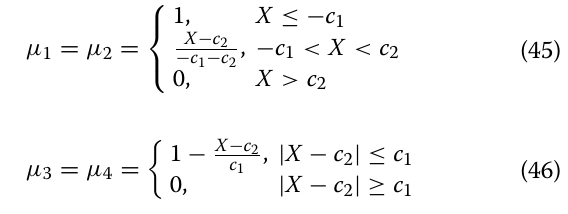
Fig. 14 Real power flow at bus 4 of IEEE 9- bus system with SPWM switching of TSC